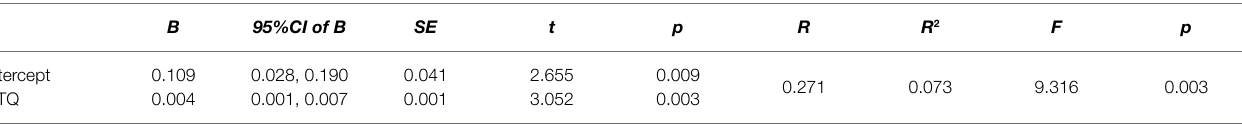
TABLE 5 | A multiple linear regression model with objects as the dependent